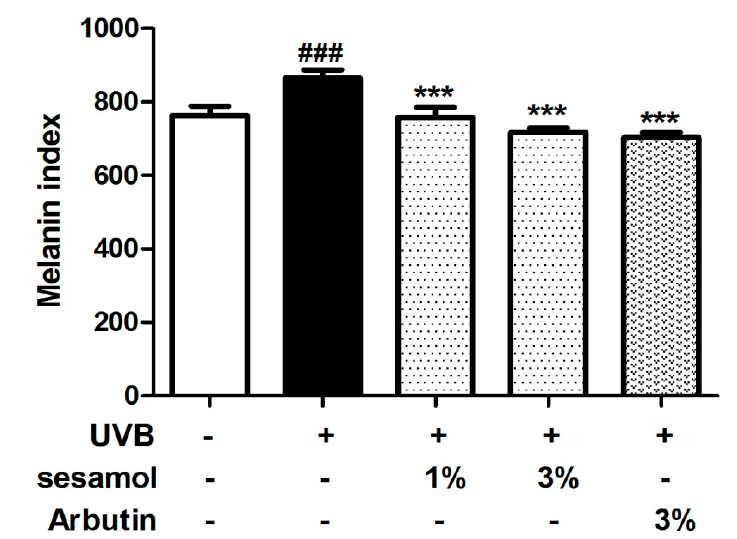
Figure 3. Effect of sesamol on the melanin index of C57BL/6 mouse ear skin post UVB irradiation in the fourth week. UVB irradiation increased the melanin index, whereas topical application of sesamol decreased the melanin index. (Significant difference versus control: ###, p < 0.001. Significant difference versus UVB-irradiated group: ***, p < 0.001.).